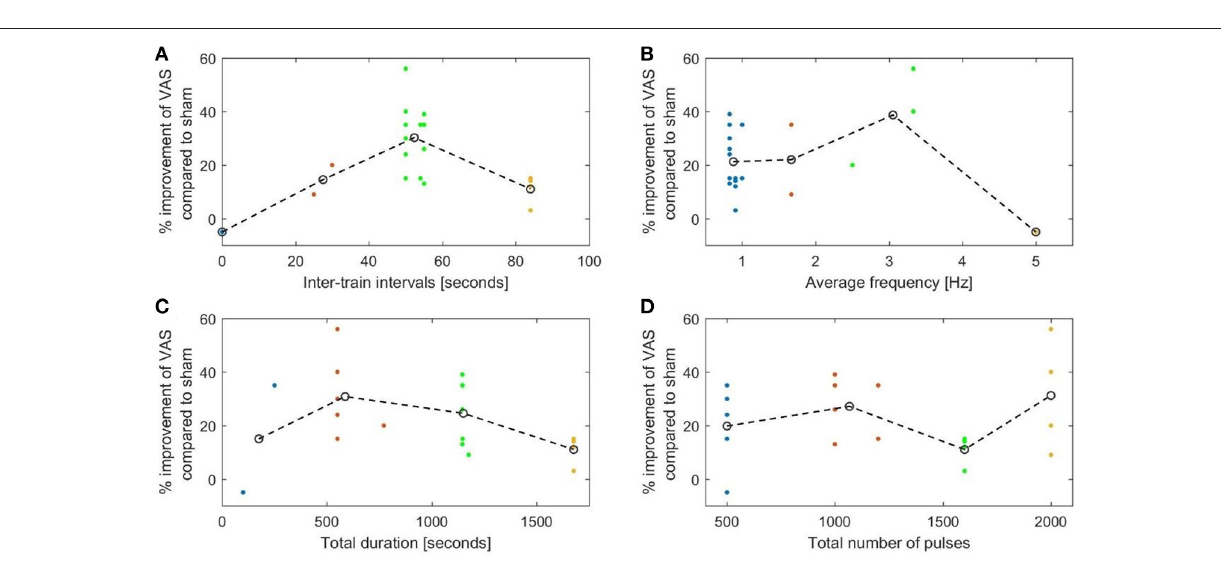
transferred to clinical studies, since no similar protocols have been used in